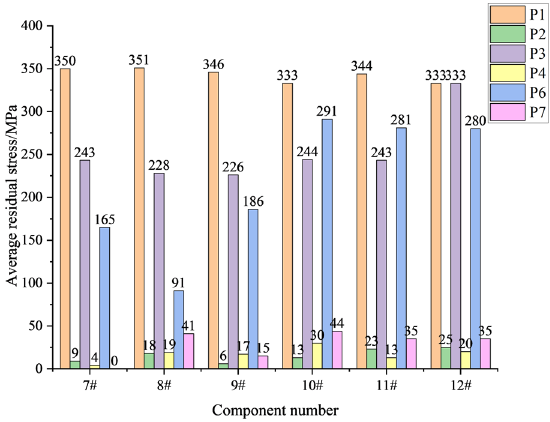
Figure 8. Average residual stress distribution of 7# to 12#.